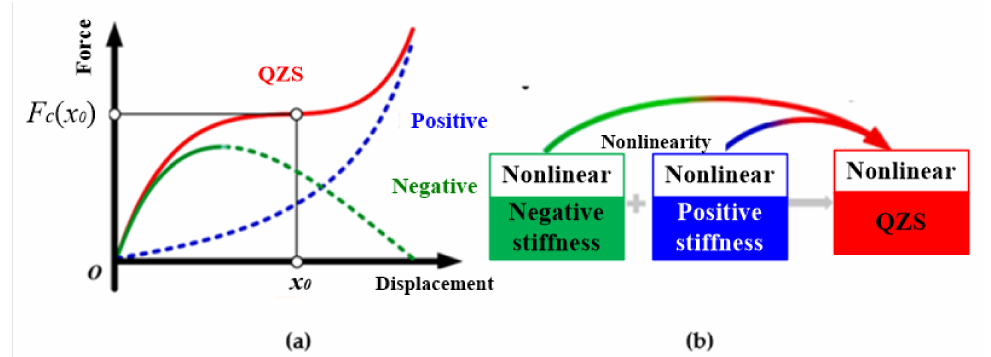
Figure 15. Nonlinear positive stiffness compensates for negative stiffness. ( a ) Force-displacement curve of QZS. ( b ) Analysis Diagram of QZS Realization. Reprinted/adapted with permission